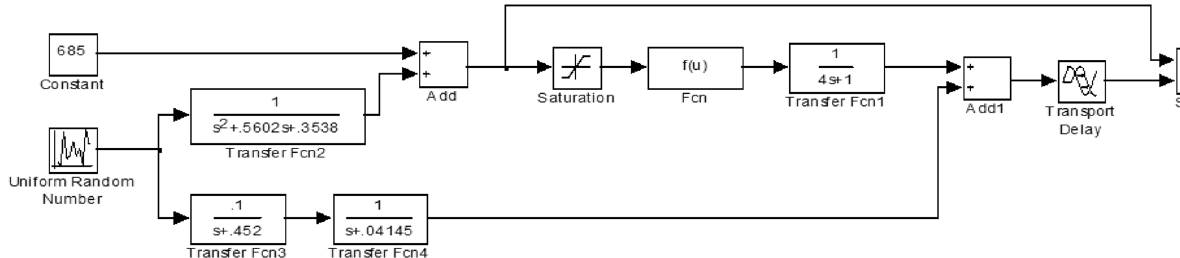
Fig. 2 Simulink model of an inertial extremal object